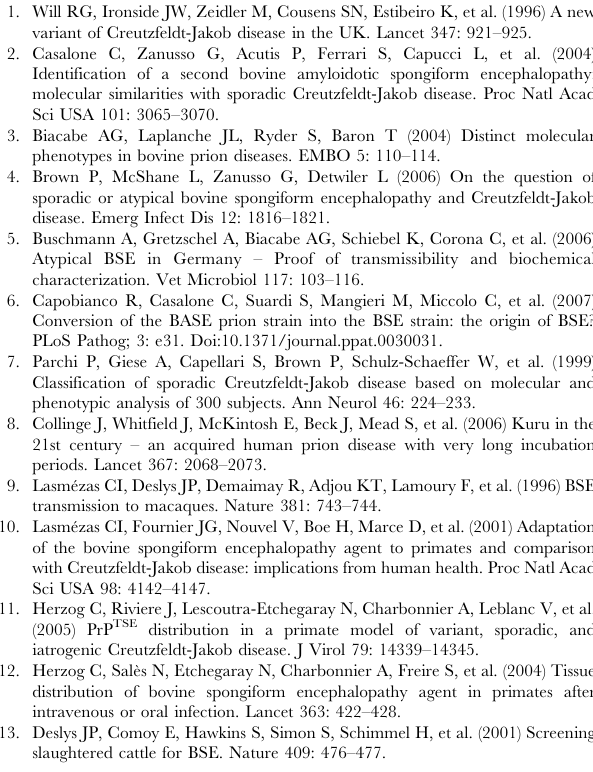
Figure S1 Resistance to proteolysis of different prion strains in sheep. PrPres from brain homogenates of sheep infected with classical scrapie, experimental cBSE, or atypical Nor-98 scrapie,